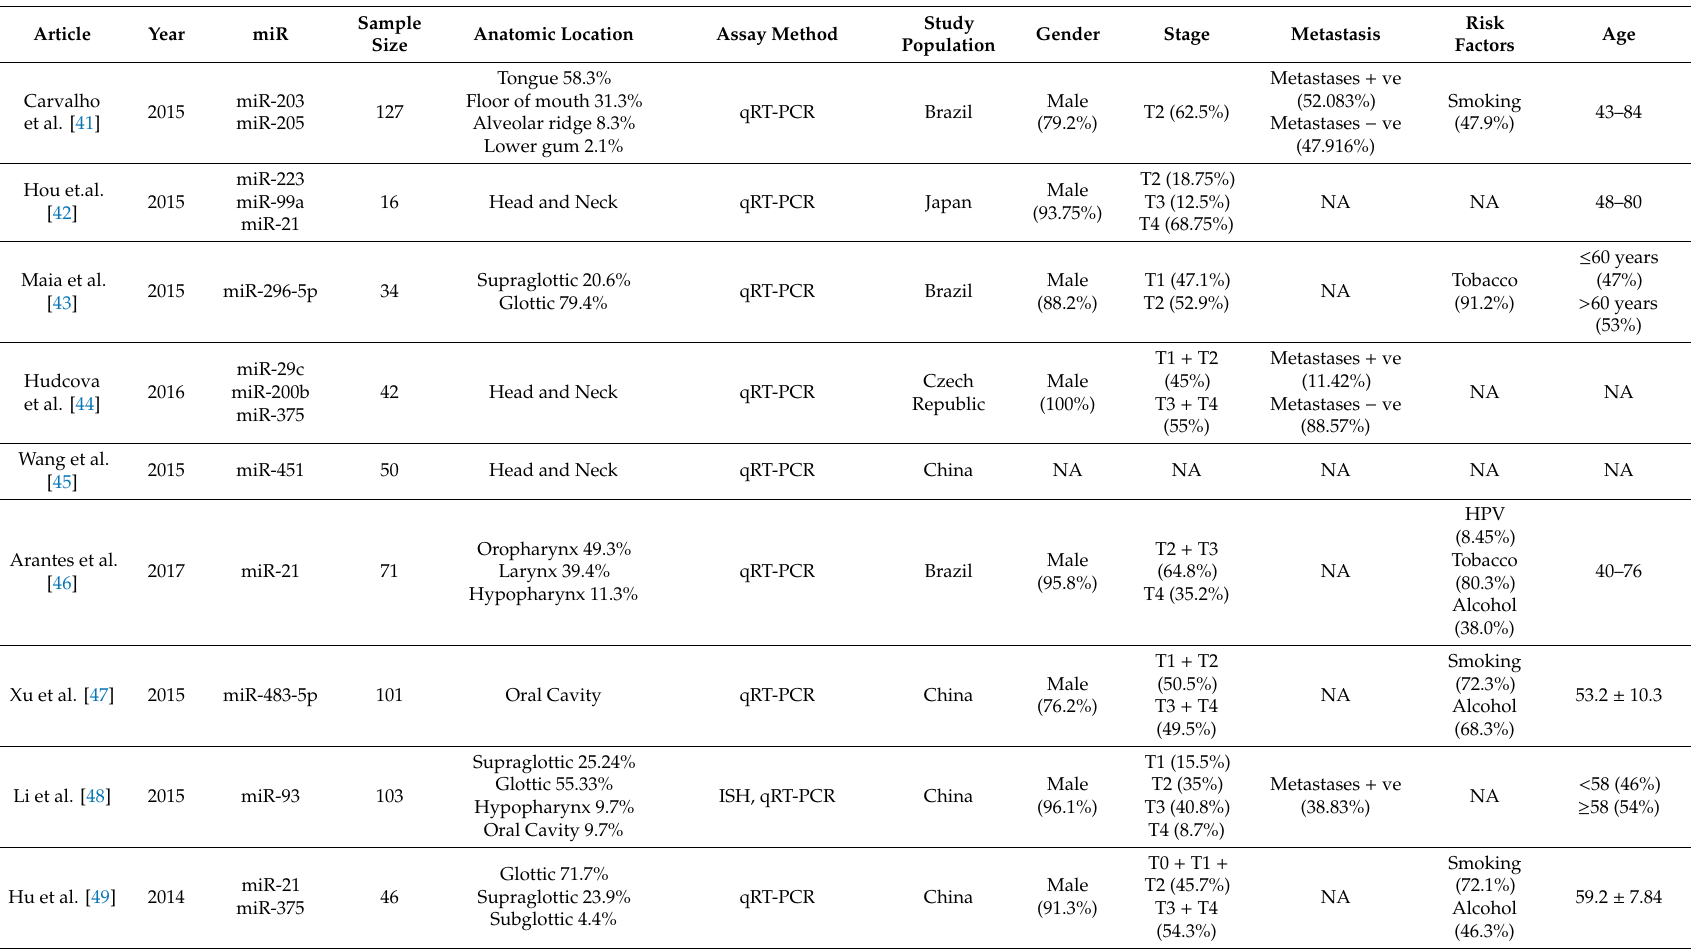
Table 1. The study and patient characteristics of all 50